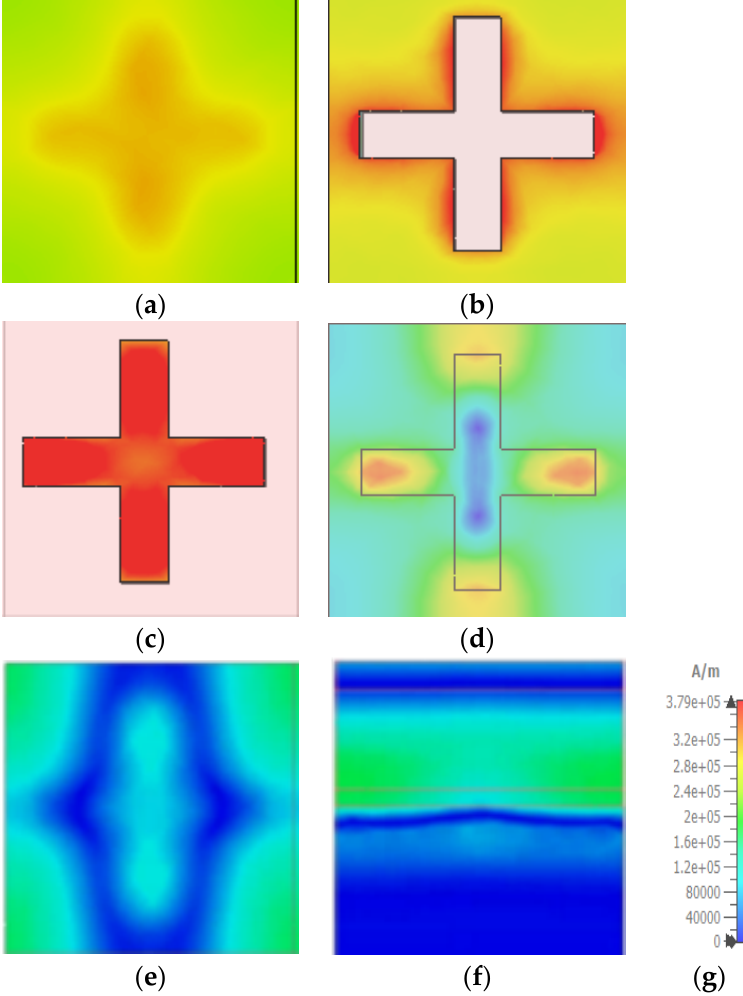
Figure 15. Magnetic field distribution at phase 560 ( a ) top SiO 2 layer ( b ) SiO 2 cover ( c ) Tungsten resonator ( d ) SiO 2 dielectric layer ( e ) Bottom tungsten layer ( f ) Side view of the MA unit cell ( g ) Unit in A/m.